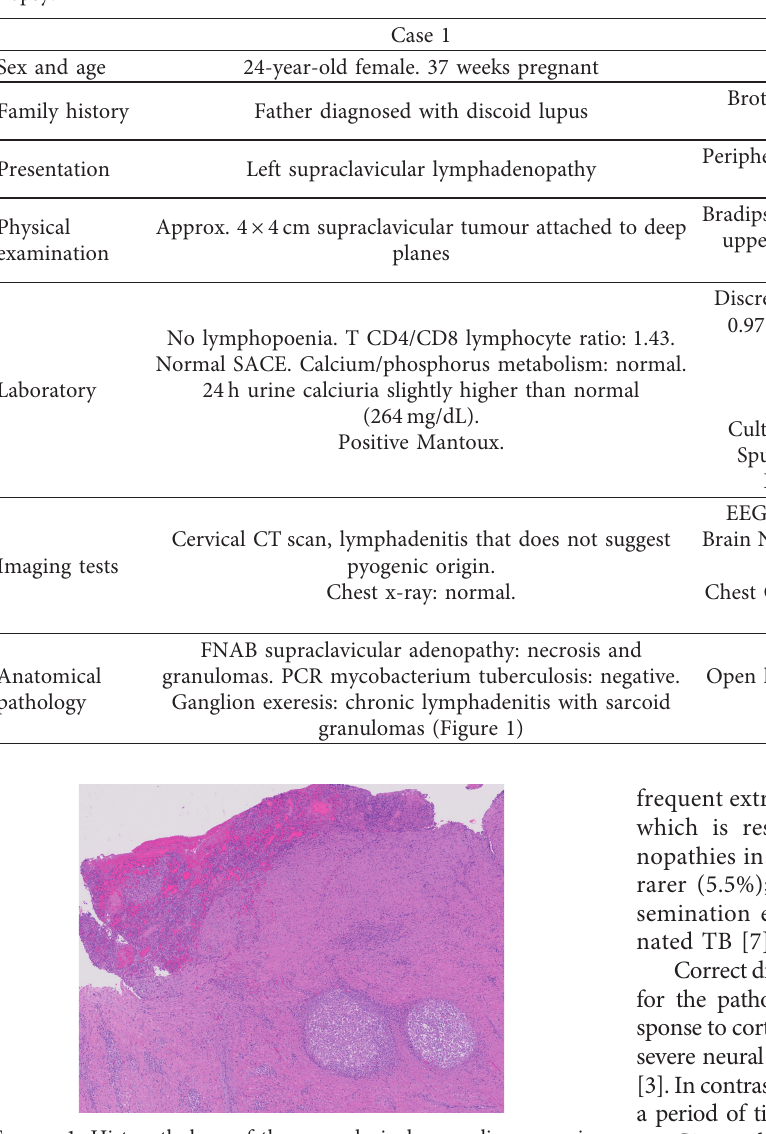
Table 1: Clinical characteristic of the two patients with necrotizing sarcoid granulomatosis. SACE: serum angiotensin-converting enzyme; ACE: angiotensin-converting enzyme; ADA: adenosine deaminase; PCR: polymerase chain reaction; BAL: bronchoalveolar lavage; AFB: acid-fastness; CT: tomography scan; EEG: electroencephalography; NMR: nuclear magnetic resonance; and FNAB: fine needle aspiration biopsy.